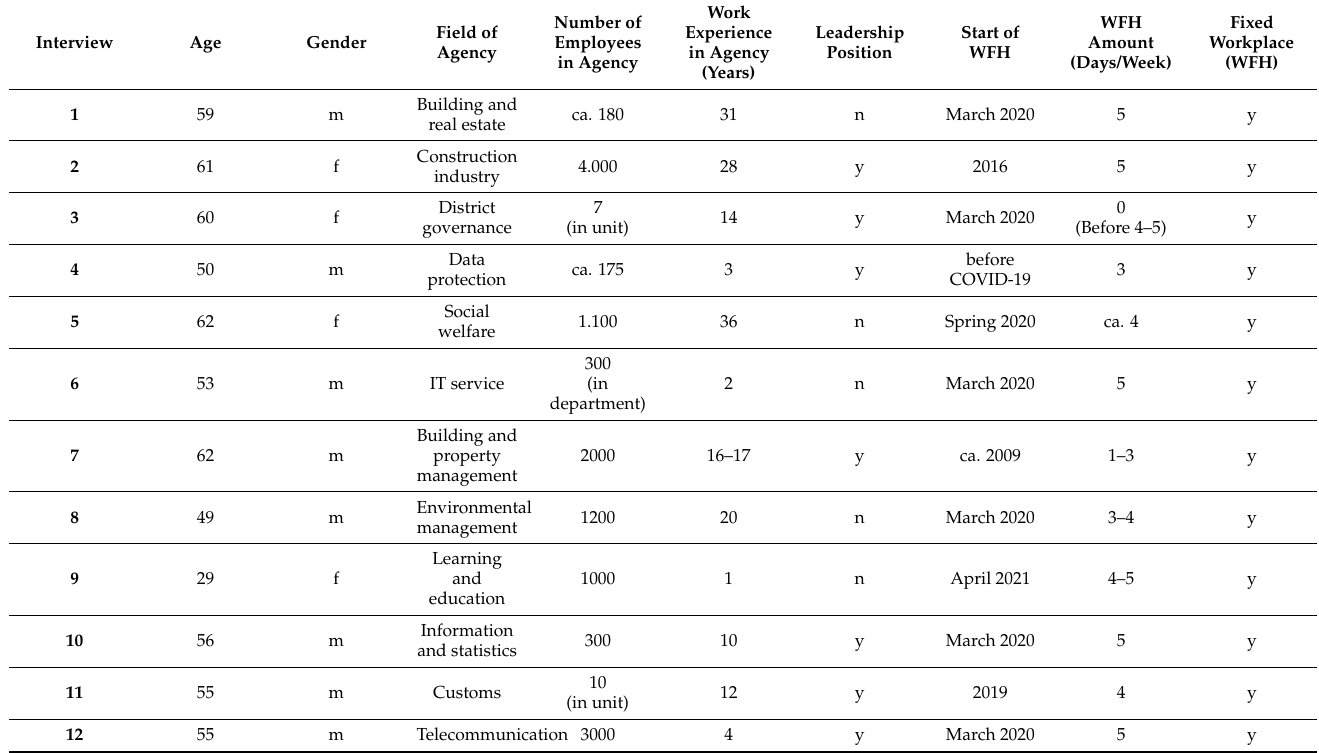
Table 1. Characteristics of the interviewed public service